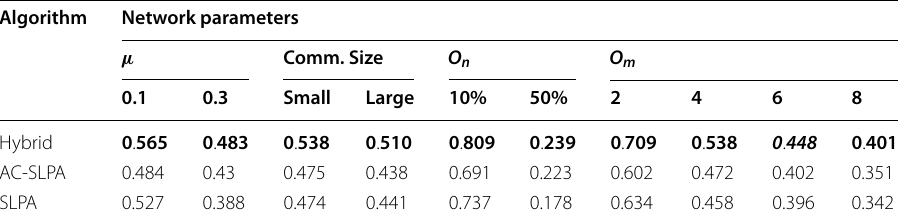
Table 13 Average NMI scores of AC-SLPA using Hybrid cleaning method compared to SLPA and AC-SLPA with noisy pairwise constraints on small synthetic networks with different parameters Algorithm